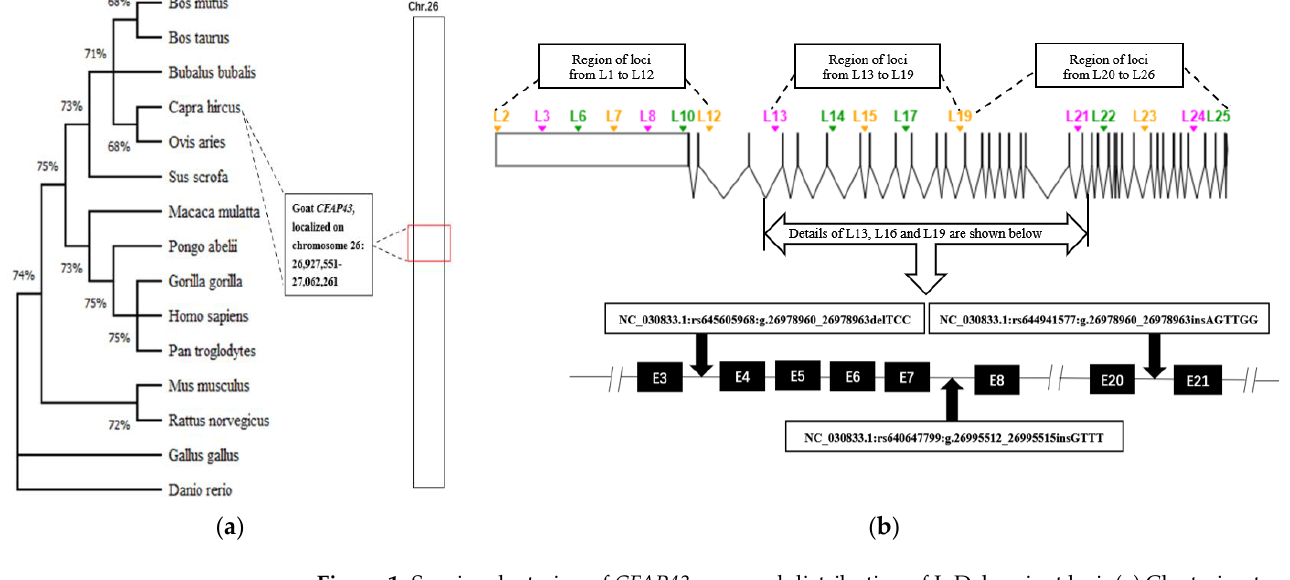
Figure 1. Species clustering of CFAP43 gene and distribution of InDel variant loci. ( a ) Clustering trees of different species on the CFAP43 gene; ( b ) distribution of identified InDel loci in the CFAP43 gene of goats. Note: The percentages on the branches in ( a ) show the percentage of data coverage of the internal nodes. The colored triangles in ( b ) represent the identified InDel loci; black boxes represent exons of the goat CFAP43 gene; and double slashes indicate omitted nucleotide sequences. Table 2. Summary of InDel site status within the CFAP43 gene in Shaanbei white cashmere goats.